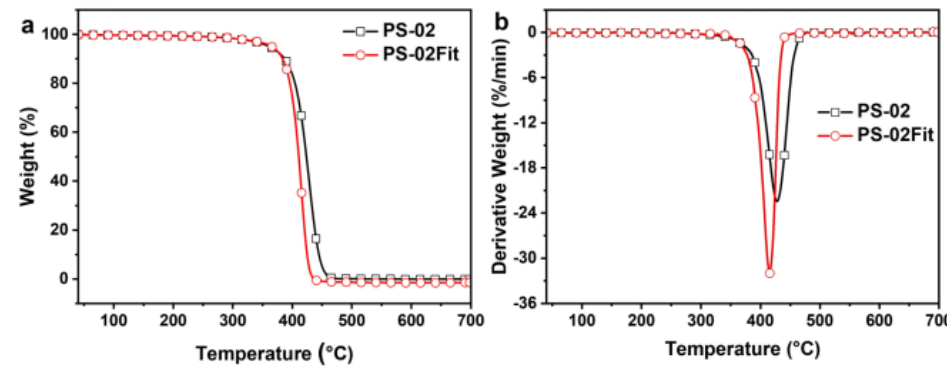
Figure 6. TG ( a ) and DTG ( b ) curves of PS-02 and PS-02Fit. Table 2. Characteristic parameters of TGA and DTG curves for BA-MA, PS, PS-02, and PS-02Fit.